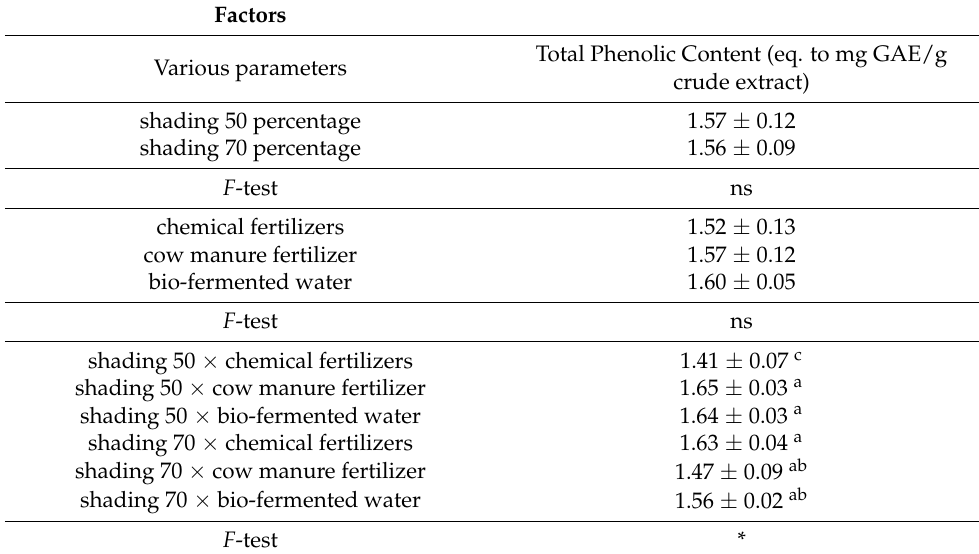
Table 3. Total phenolic content of Niamhom